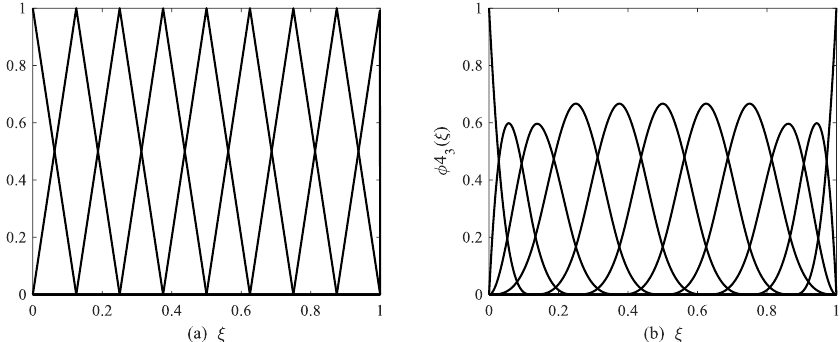
Figure 2. BSWI scaling functions using different orders on the interval [0, 1] [15,16] . ( a ) BSWI23 ( b ) BSWI43